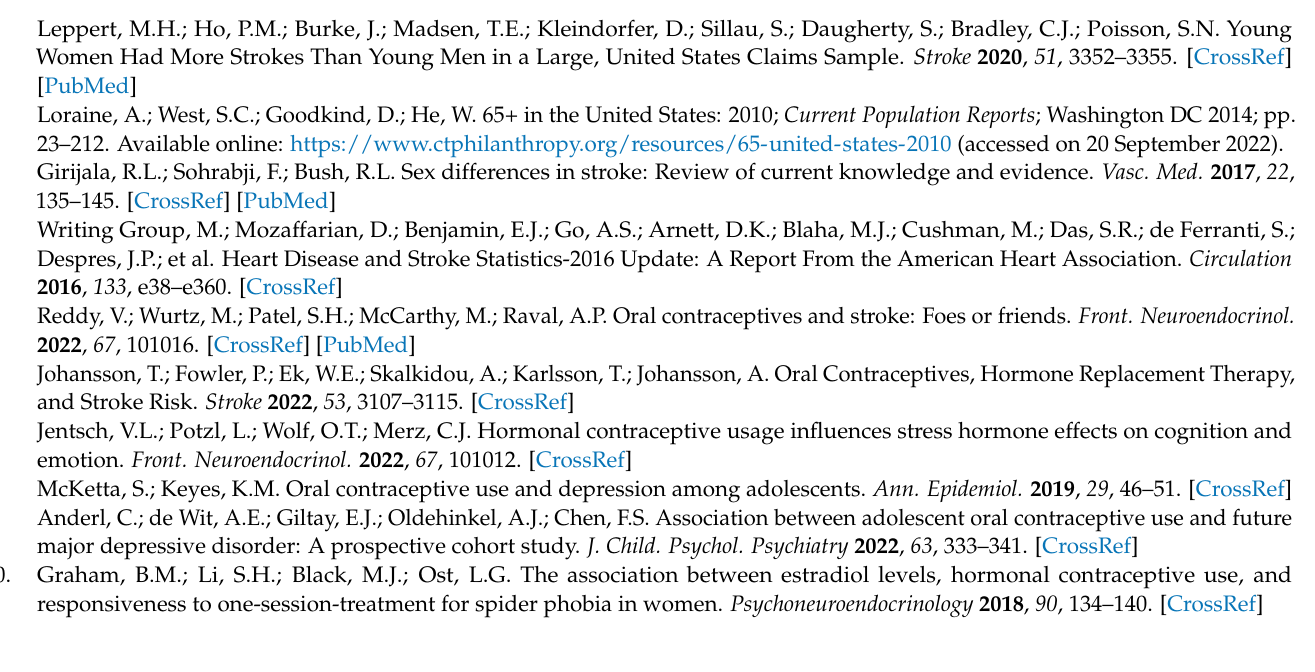
Table S3a: Acyl Carnitine Metabolism in the Cortex of Adolescent Female Rats; Table S3b: Acyl Carnitine Metabolism in the Cortex of Adult Female Rats; Table S4a: Carnitine Metabolism, Ketone Bodies, Acetylcholine, Acyl Choline, and Monohydroxy Metabolites in the Cortex of Adolescent Female Rats; Table S4b: Carnitine Metabolism, Ketone Bodies, Acetylcholine, Acyl Choline, and Monohydroxy Metabolites in the Cortex of Adult Female Rats; Table S5a: Phosphatidylcholine (PC) Concentrations Metabolites in the Cortex of Adolescent Female Rats; Table S5b: Phosphatidylcholine (PC) Concentrations Metabolites in the Cortex of Adult Female